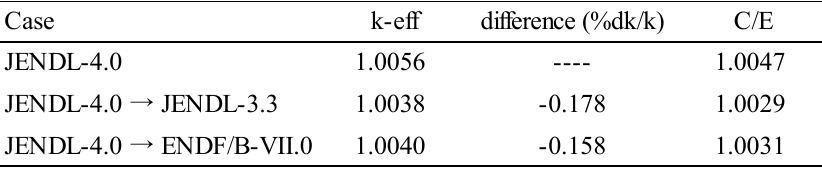
Table V. Effect of 232 Th cross section change on k